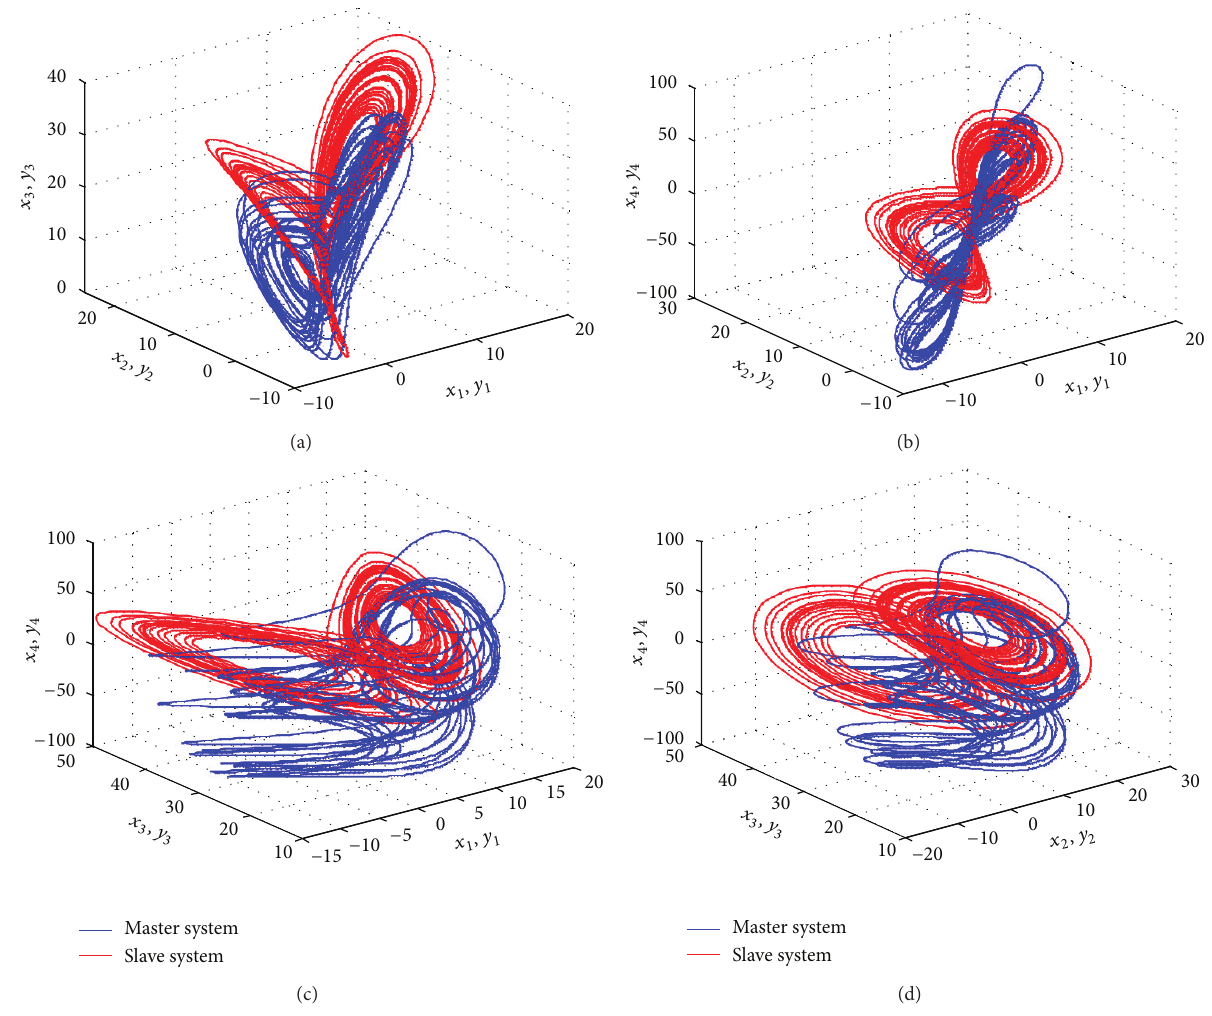
Figure 1: Projections of phase portrait for master system (11) and slave system